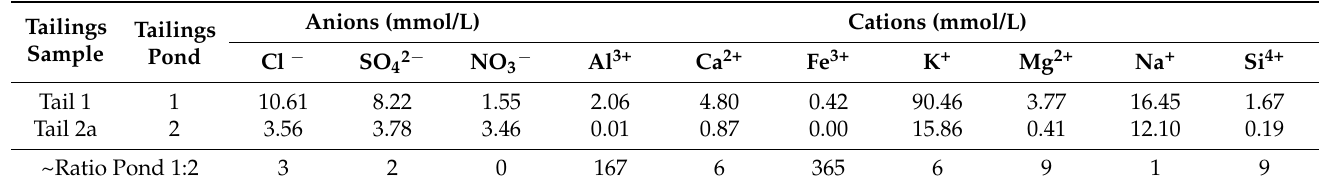
Table 4. Results of ion chromatography analysis of the tailings liquids.